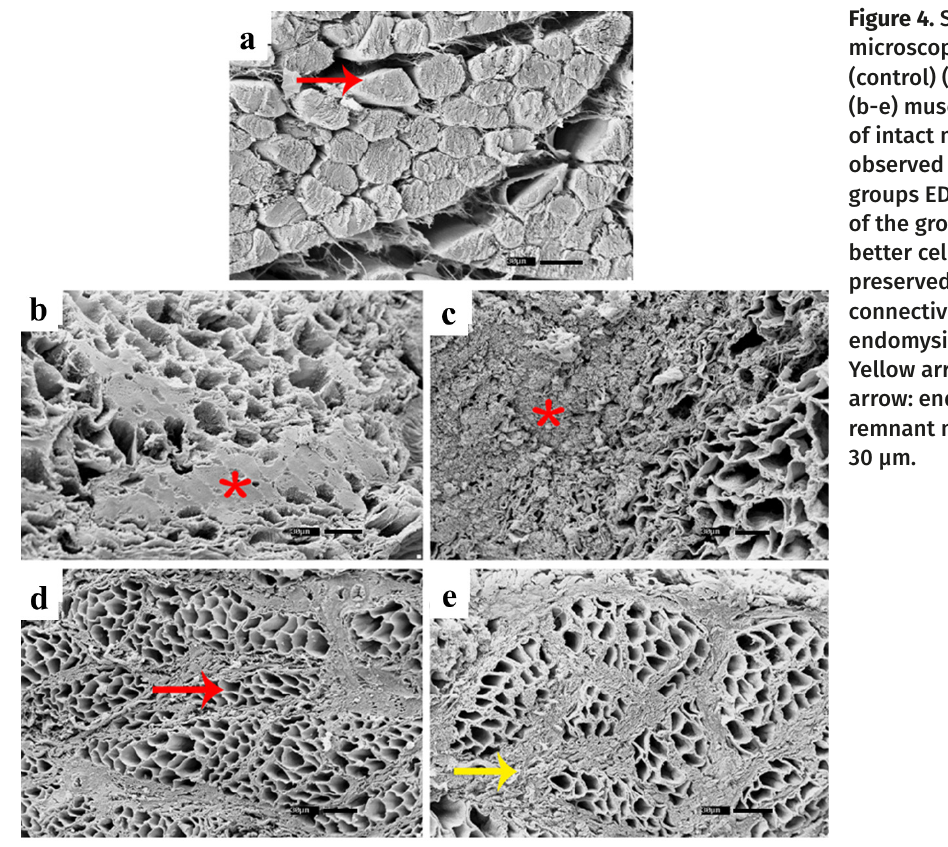
Figure 4. Scanning electron microscopy of the native (control) (a) and decellularized (b-e) muscles. The presence of intact muscle fibers was observed in samples of the groups EDTA+Tris (b-c), whereas of the groups SDS (d-e) showed better cell removal and preserved microfibers of the connective tissue, including endomysium and perimysium. Yellow arrow: perimysium. Red arrow: endomysium. Asterisk (*): remnant muscle fibers. Scale bar: 30